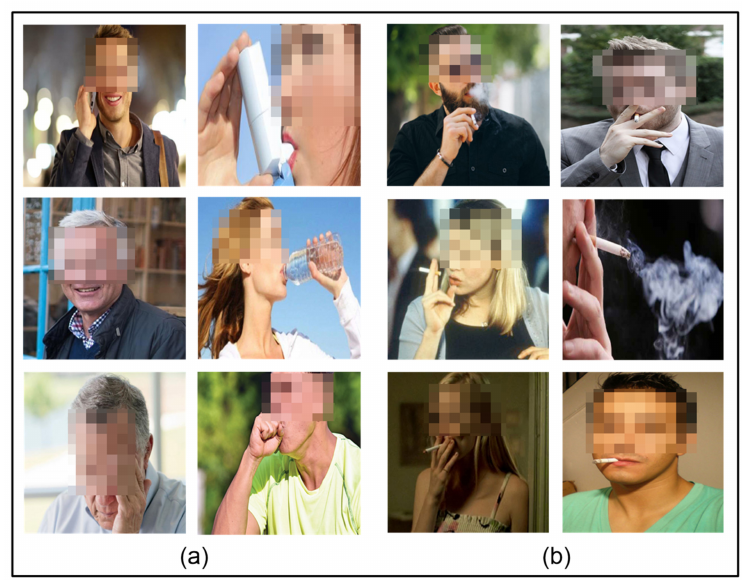
Figure 4. Images of ( a ) NotSmoking class and ( b ) Smoking class.